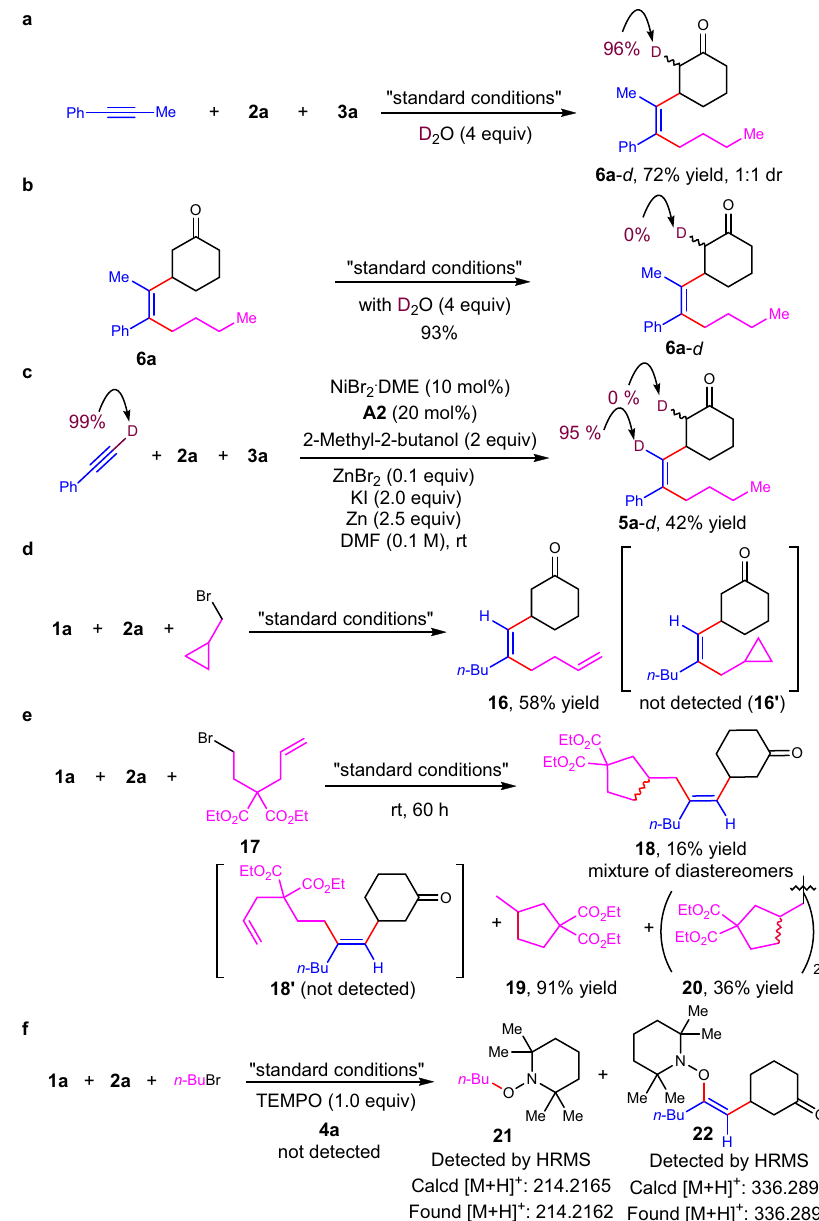
Fig. 6 Mechanistic investigations and control experiments. a Reaction in the presence of deuterated water. b Treat the product 6a under reaction conditions with deuterated water. c The reaction of deuterated phenylacetylene. d Radical clock reaction using cylcopropylmethylbromide. e Radical clock reaction using 17 . f Radical trap with